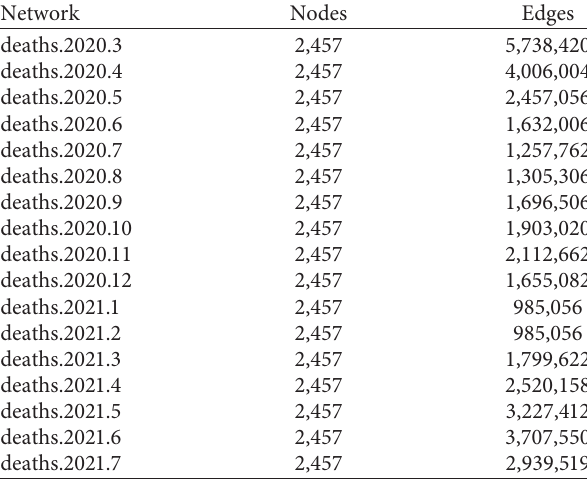
Table 3: Main characteristics for suspect cases networks. Network Nodes Edges